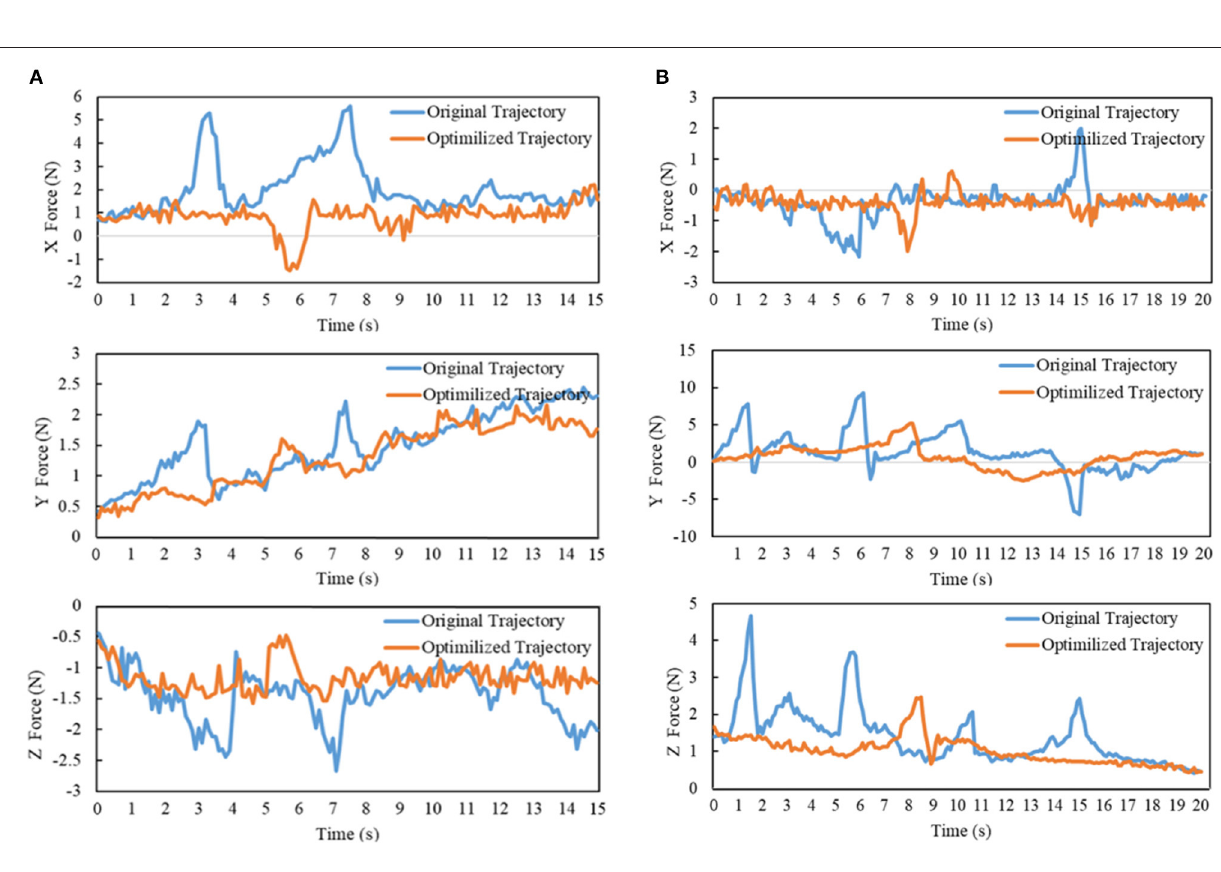
position only when the force exceeds the dead zone